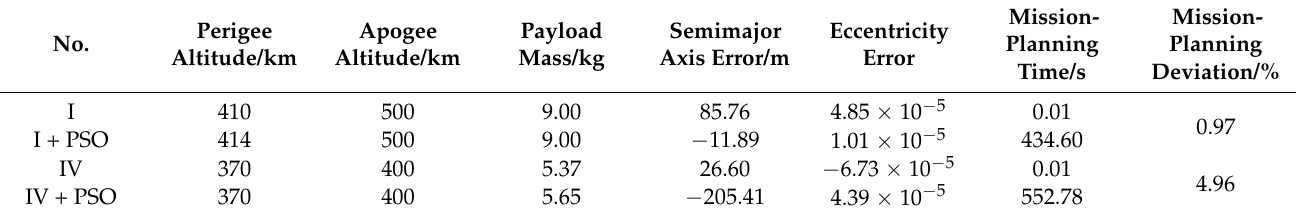
Table 5. Effectiveness results of mission decision making and trajectory